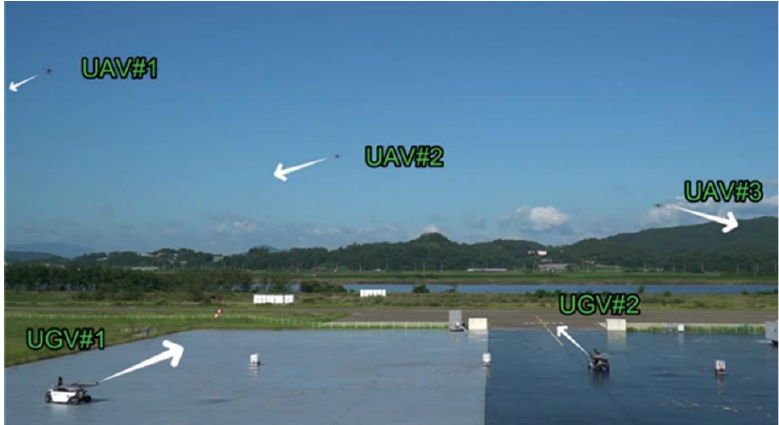
Figure 15. Operation of multiple UGVs/UAVs.